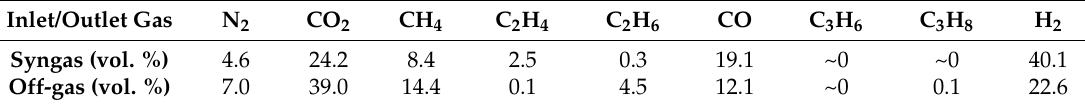
Table A1. Average composition of Inlet/Outlet Gases under BL condition [12].